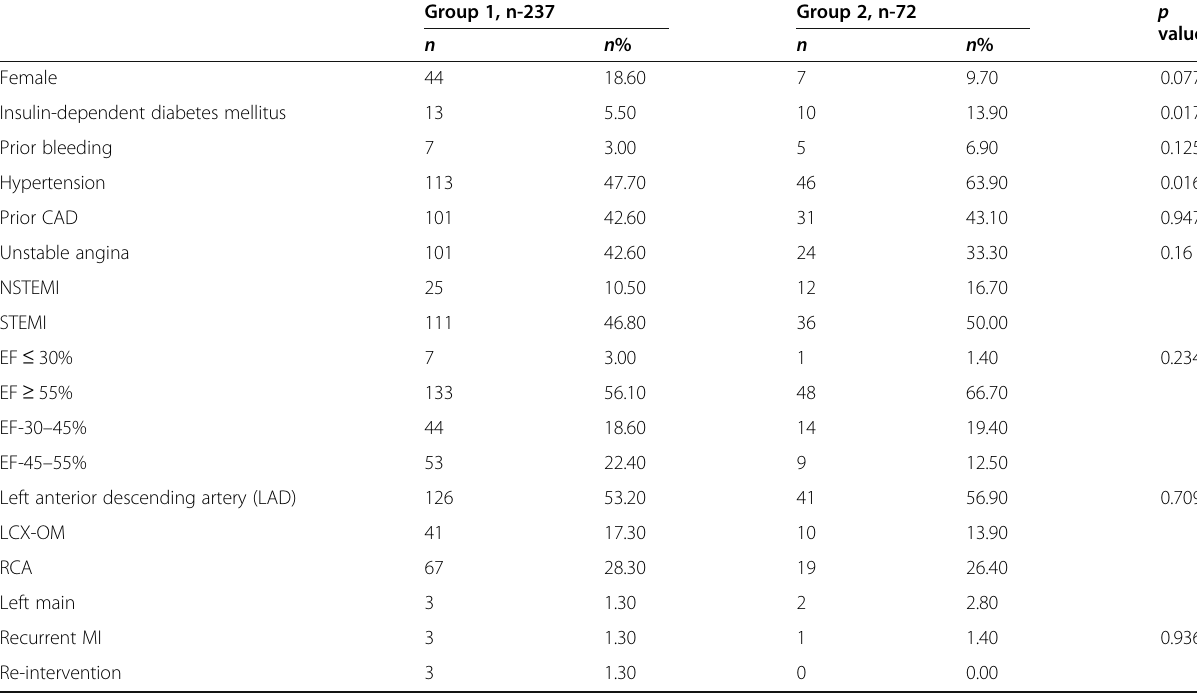
Table 2 Clinical outcomes in ticagrelor discontinued group and ticagrelor continued